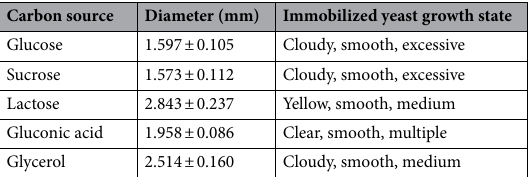
Table 3. Effect of different carbon sources on immobilized yeast.